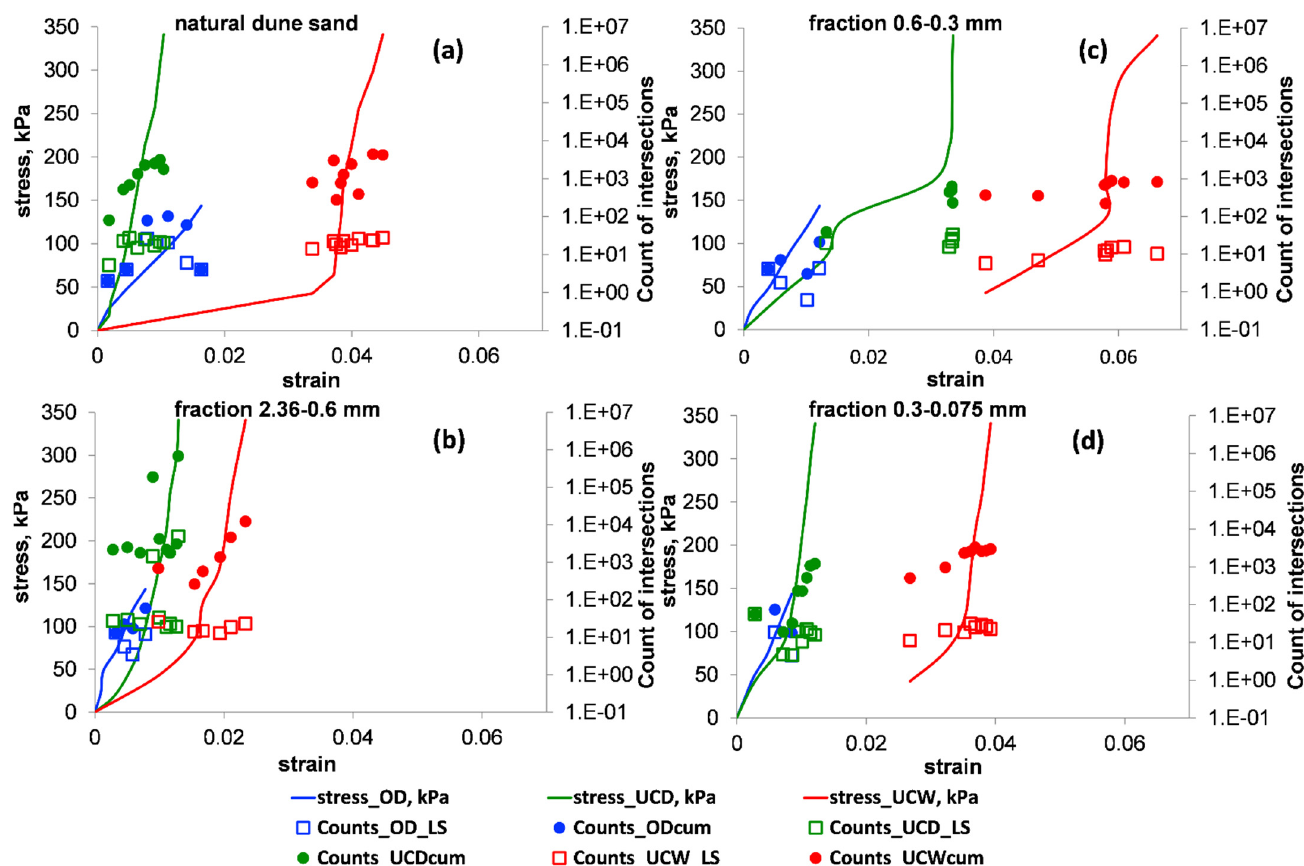
Figure 9. The stress–strain relationships (solid curves) vs. the values of the counts for the OD (blue), UCD (green) and UCW (red) tests. The empty squares and the full circles denote the values of average (index = LS) and cumulative (index = cum) counts for a load stage, respectively. Panels ( a – d ) show the results for natural dune sand and its three extracted fractions: 2.36–0.6, 0.6–0.3 and 0.3–0.075 mm, respectively. Note that in the used number format, the notation “E ± xx” is part of a scientific notation and corresponds to “ · 10 ± xx